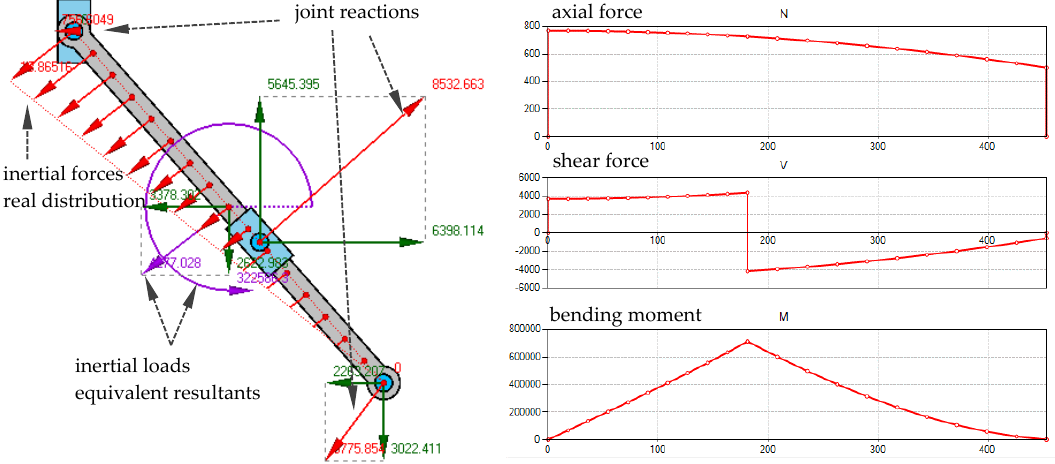
Figure 13. Free solid and internal efforts’ diagrams.